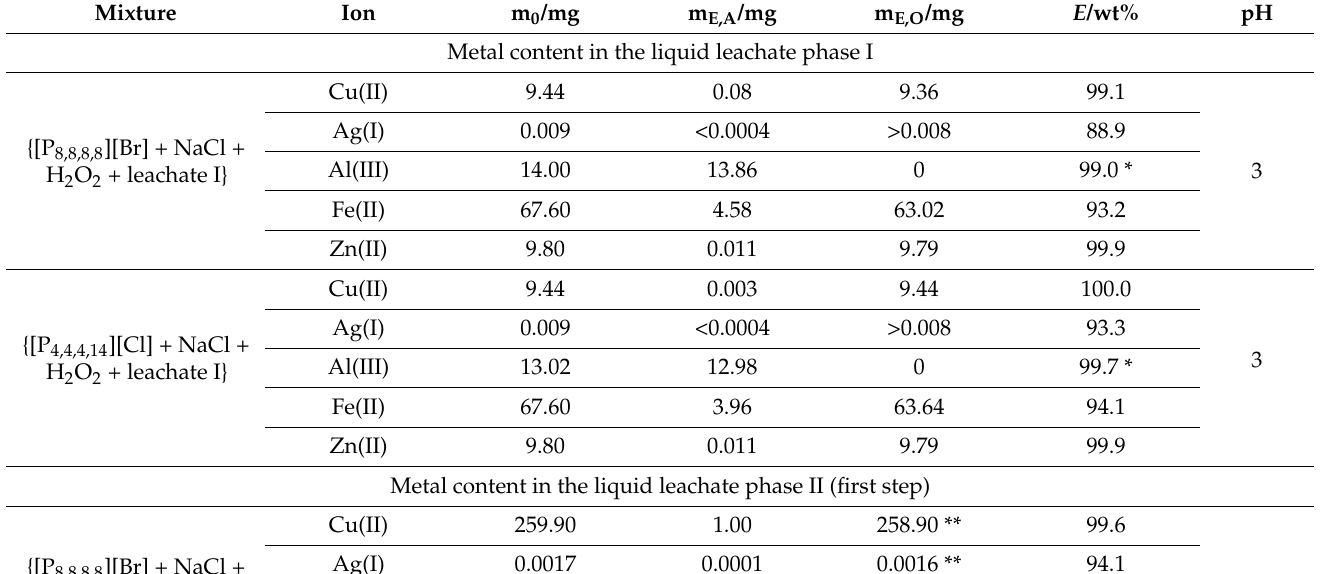
Table 8. Results of metals extraction with ABS method from the post-leaching solutions I and II at pH = 3, extraction efficiency ( E /wt%), pH of the aqueous phase after extraction at the temperature T = 303